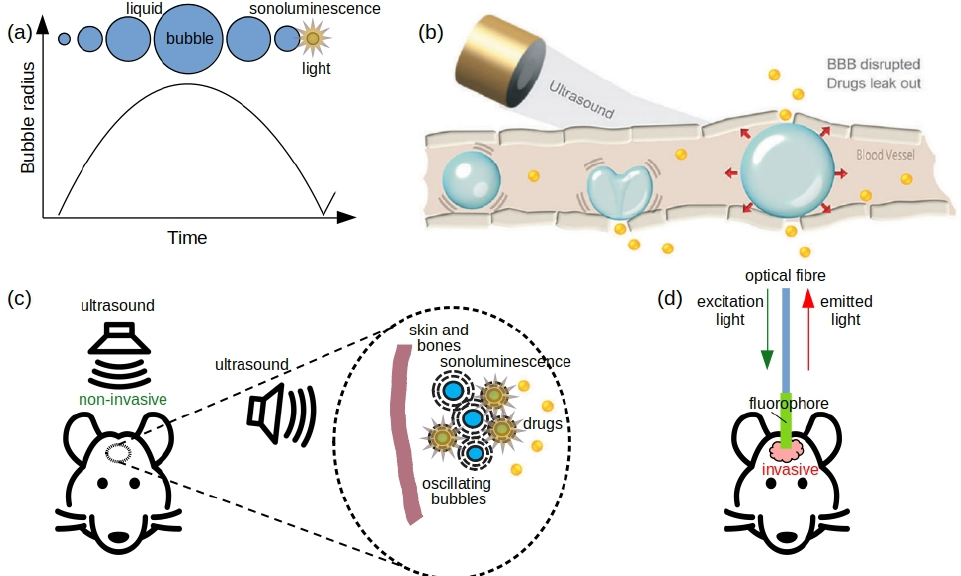
Figure 1. ( a ) Schematic radius vs. time diagram for a gas bubble oscillating in the bulk of water. Bubble shapes at different times are shown above the curve during a single oscillation cycle. The pressure inside a bubble is high at the beginning and at the end of the oscillation cycle and is low in the middle. ( b ) Illustration of the principle of drug delivery through the blood–brain barrier (BBB) using gas bubbles inside a small blood vessel of the brain. Bubble oscillations are driven by an ultrasound wave transducer located outside the head, and the drug (small spheres in the picture) passes through the wall of the blood vessel when the bubble either reaches its maximum radius or collapses and forms a water jet. Reproduced from [11] under the terms of a Creative Commons license. ( c ) Sketch of a potential scheme of drug delivery with gas bubbles and subsequent drug photoactivation with sonoluminescence UV spectral range light. ( d ) Illustration of an idealised fluorescence-based fibre-optic probe that can be used for imaging, sensing, and drug photoactivation inside a living